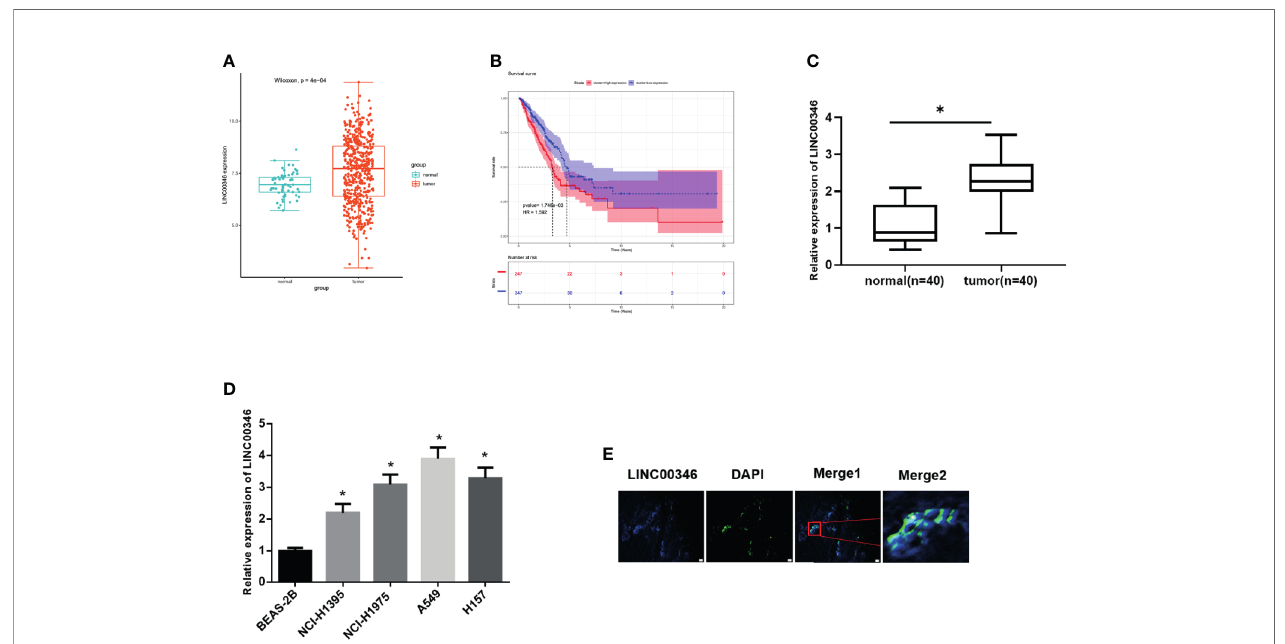
FIGURE 1 | LINC00346 is up-regulated in LUAD tissues and cells, and is mainly located in the cytoplasm. (A) The expression of LINC00346 in normal (green) and tumor (red) samples; (B) The correlation between the expression level of LINC00346 (red for high-expression group and blue for low-expression group) and overall survival in LUAD patients was analyzed by Kaplan-Meier survival analysis; (C) The expression of LINC00346 in 40 pairs of clinical LUAD and para-cancerous tissues, and (D) in normal bronchial epithelial cell line and LUAD cell lines were measured by qRT-PCR; (E) FISH was used to detect the localization of LINC00346 in LUAD. * P <